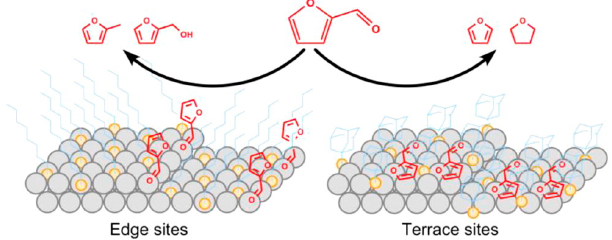
Figure 11. Site isolation and selective blocking effects for the selective hydrogenation of furfural Reproduced with permission from ref. [84]. Copyright2014, American Chemical Society.